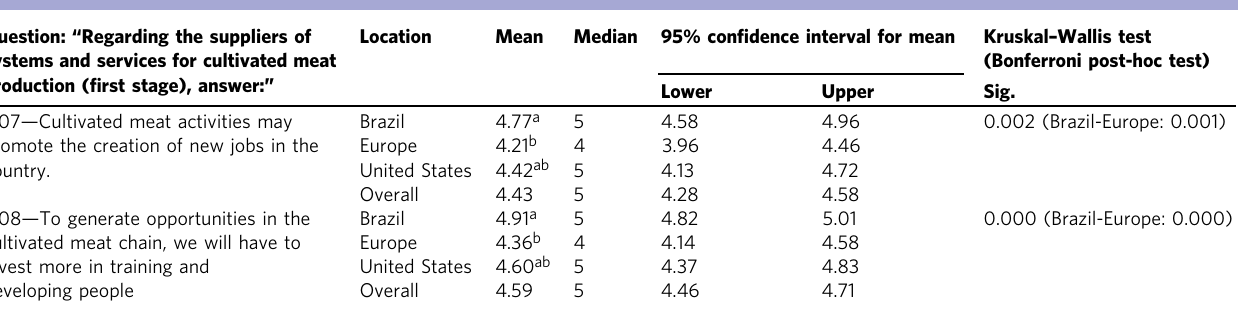
Table 6 Responses to questions regarding the impact of the fi rst stage of the cultivated meat value chain on jobs and quali fi cations in Brazil ( N = 35), Europe ( N = 56) and the United States ( N = 45) using Likert scale from 1 (strongly disagree) to 5 (strongly agree), from August to October,